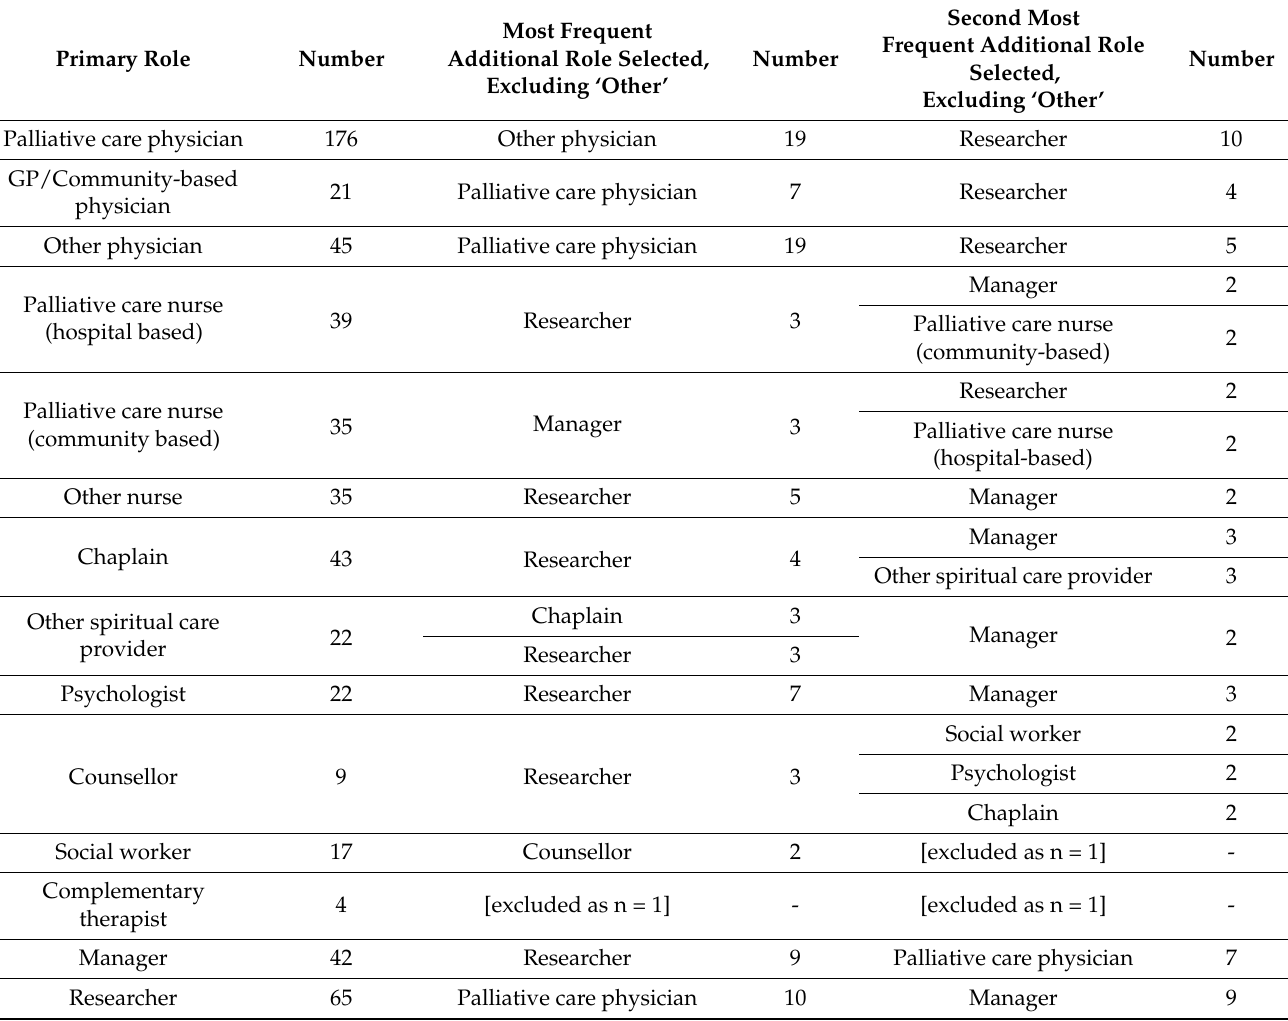
Table 4. Additional roles identified (Q9 drop-down